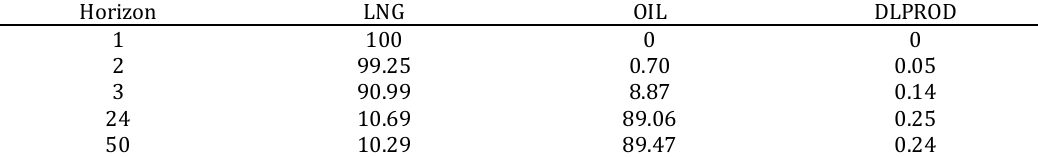
Table 3: Percent contribution of shocks to the overall variability of the LNG prices Horizon LNG OIL DLPROD 1 100 0 0 2 99.25 0.70 0.05